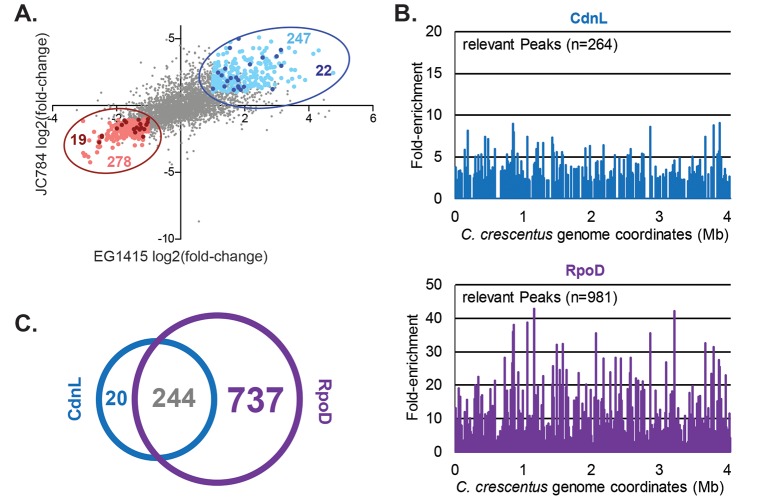
Transcriptional changes in ΔcdnL are broad and mostly indirect.A. Plot comparing the log2(fold-change) of ΔcdnL compared to WT for each transcript in the two transcriptomics datasets: microarray of JC784 and RNA-seq of EG1415. Pearson’s correlation = 0.6331. The 278 genes at least 2-fold downregulated in both datasets are highlighted in pink and the 247 genes at least 2-fold upregulated in both are highlighted in light blue. Putative direct targets of CdnL that are at least 2-fold altered in ΔcdnL in both datasets are highlighted in red and dark blue (listed in S3 Table). B. Peaks representing fold-enrichment of loci across the genome immunoprecipitated using CdnL (blue) or RpoD (purple) antibodies. C. Intersection of the peaks enriched at least 2-fold with CdnL or RpoD antibodies by ChIP-seq.